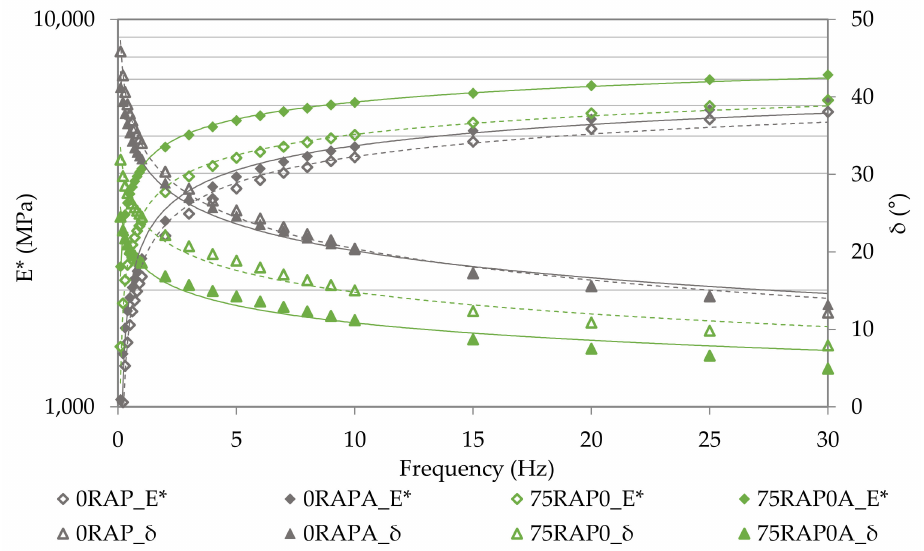
Figure 6. ( left ) Stiffness modulus; ( right ) Phase angle. E* is the stiffness modulus